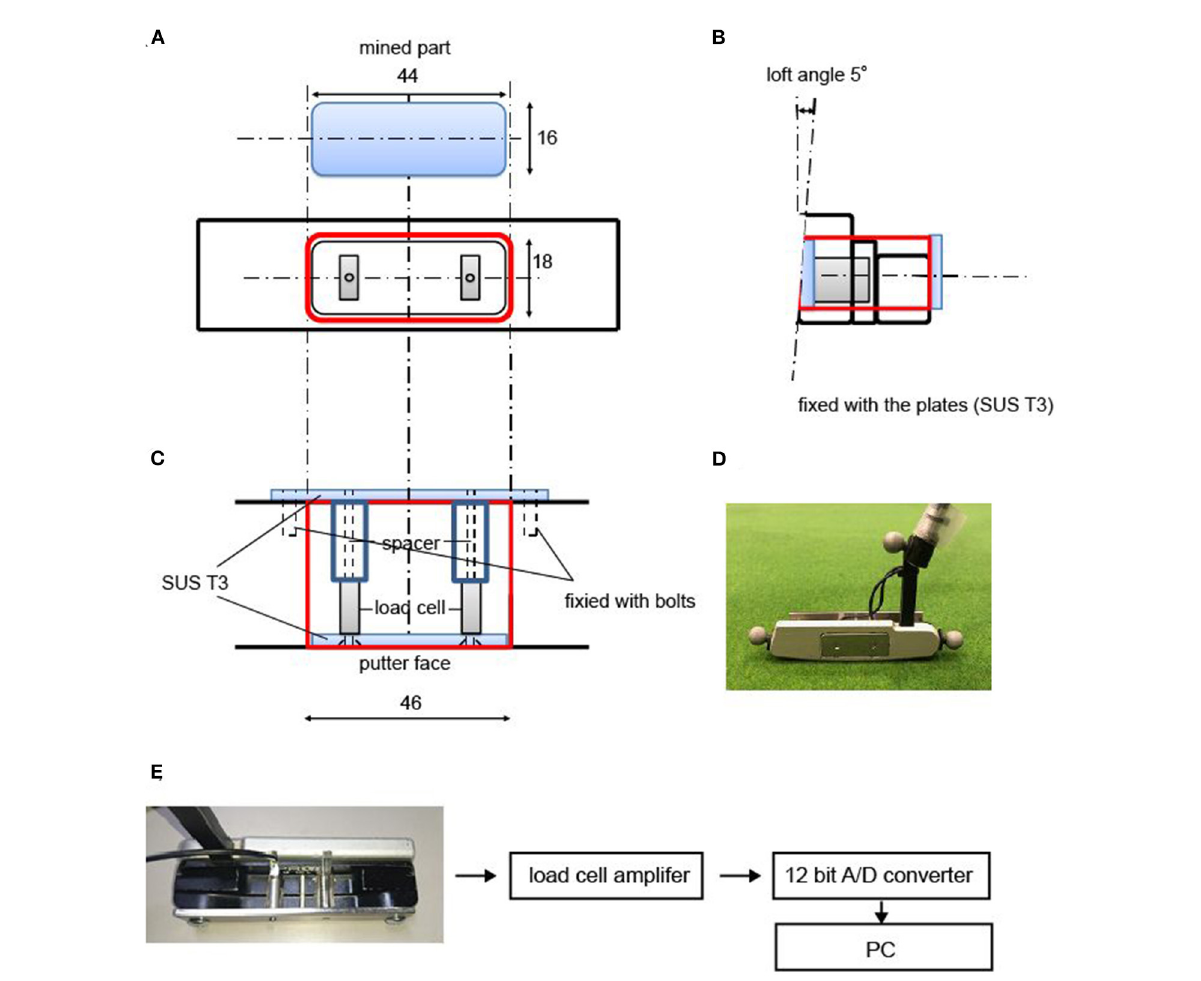
FIGURE2 The putter equipped with the collision pressure measuring device. (A) shows the mined part of the putter face, the position, and the size of the equipped device. (B) shows an image from the side view of the device. (C) shows an image of the device from above. (D) is a photograph taken from the front of the putter equipped with the device used in the measurement. The markers for the motion capture system are affixed to the toe, heel, and neck of the putter head. (E) is a schematic diagram of the system. All numerical units in the figure are